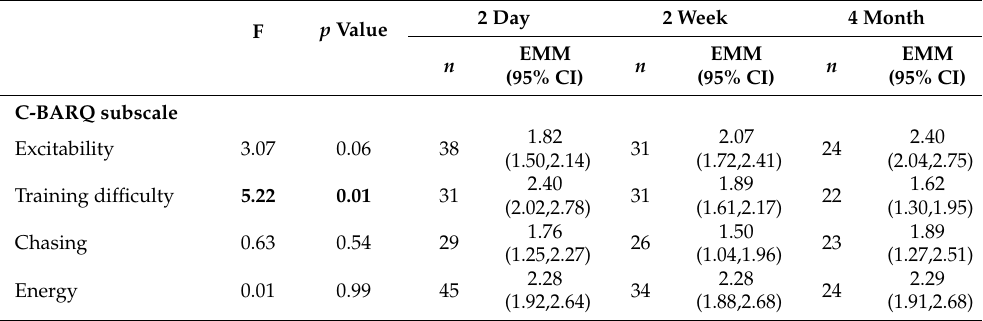
Table 5. Linear mixed models showing change in normally distributed C-BARQ subscale scores and miscellaneous items following